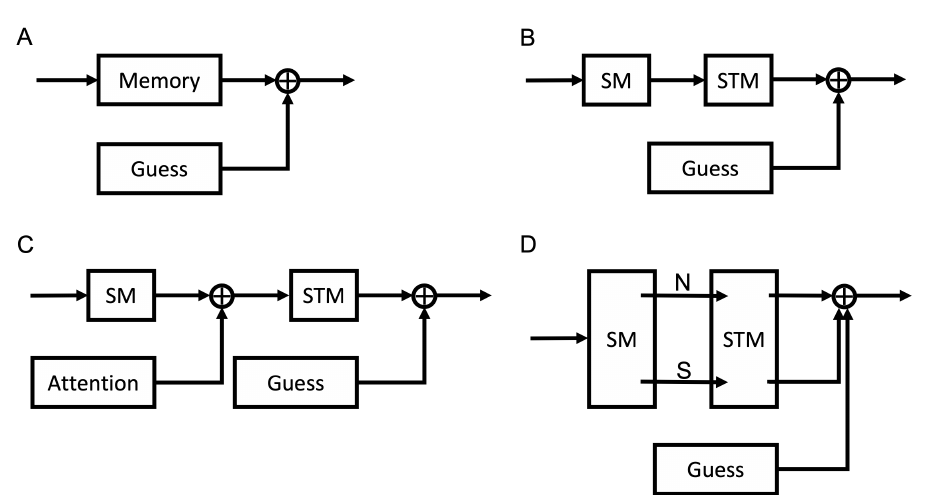
Figure 3. Block diagrams of the different models investigated. ( A ) Model A, one Gaussian + uniform mixture model. ( B ) Model B, with memory represented as a concatenation of SM and STM. This is still a one Gaussian + uniform mixture model. ( C ) Model C has attention added to the model, with the SM block being pre-attentive. The resulting model is a two Gaussians + uniform mixture model. ( D ) Model D divides the SM and STM stages into two parallel sections. This also represents a two Gaussians + uniform mixture